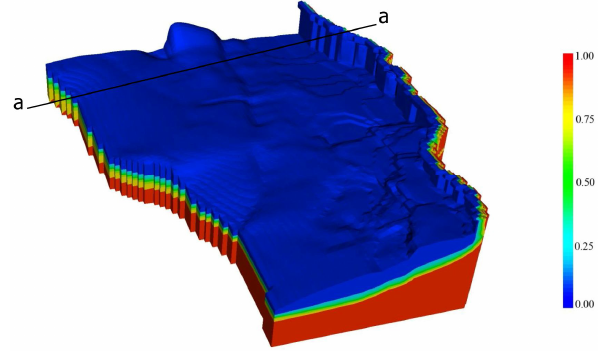
Fig. 8. Variable-density flow simulation without anthro- pogenic stresses. Figure 8: Variable density flow simulation without anthropogenic stresses. The legend label shows the c=c model /35mgl − 1 parameter c=c model /35 mg/l